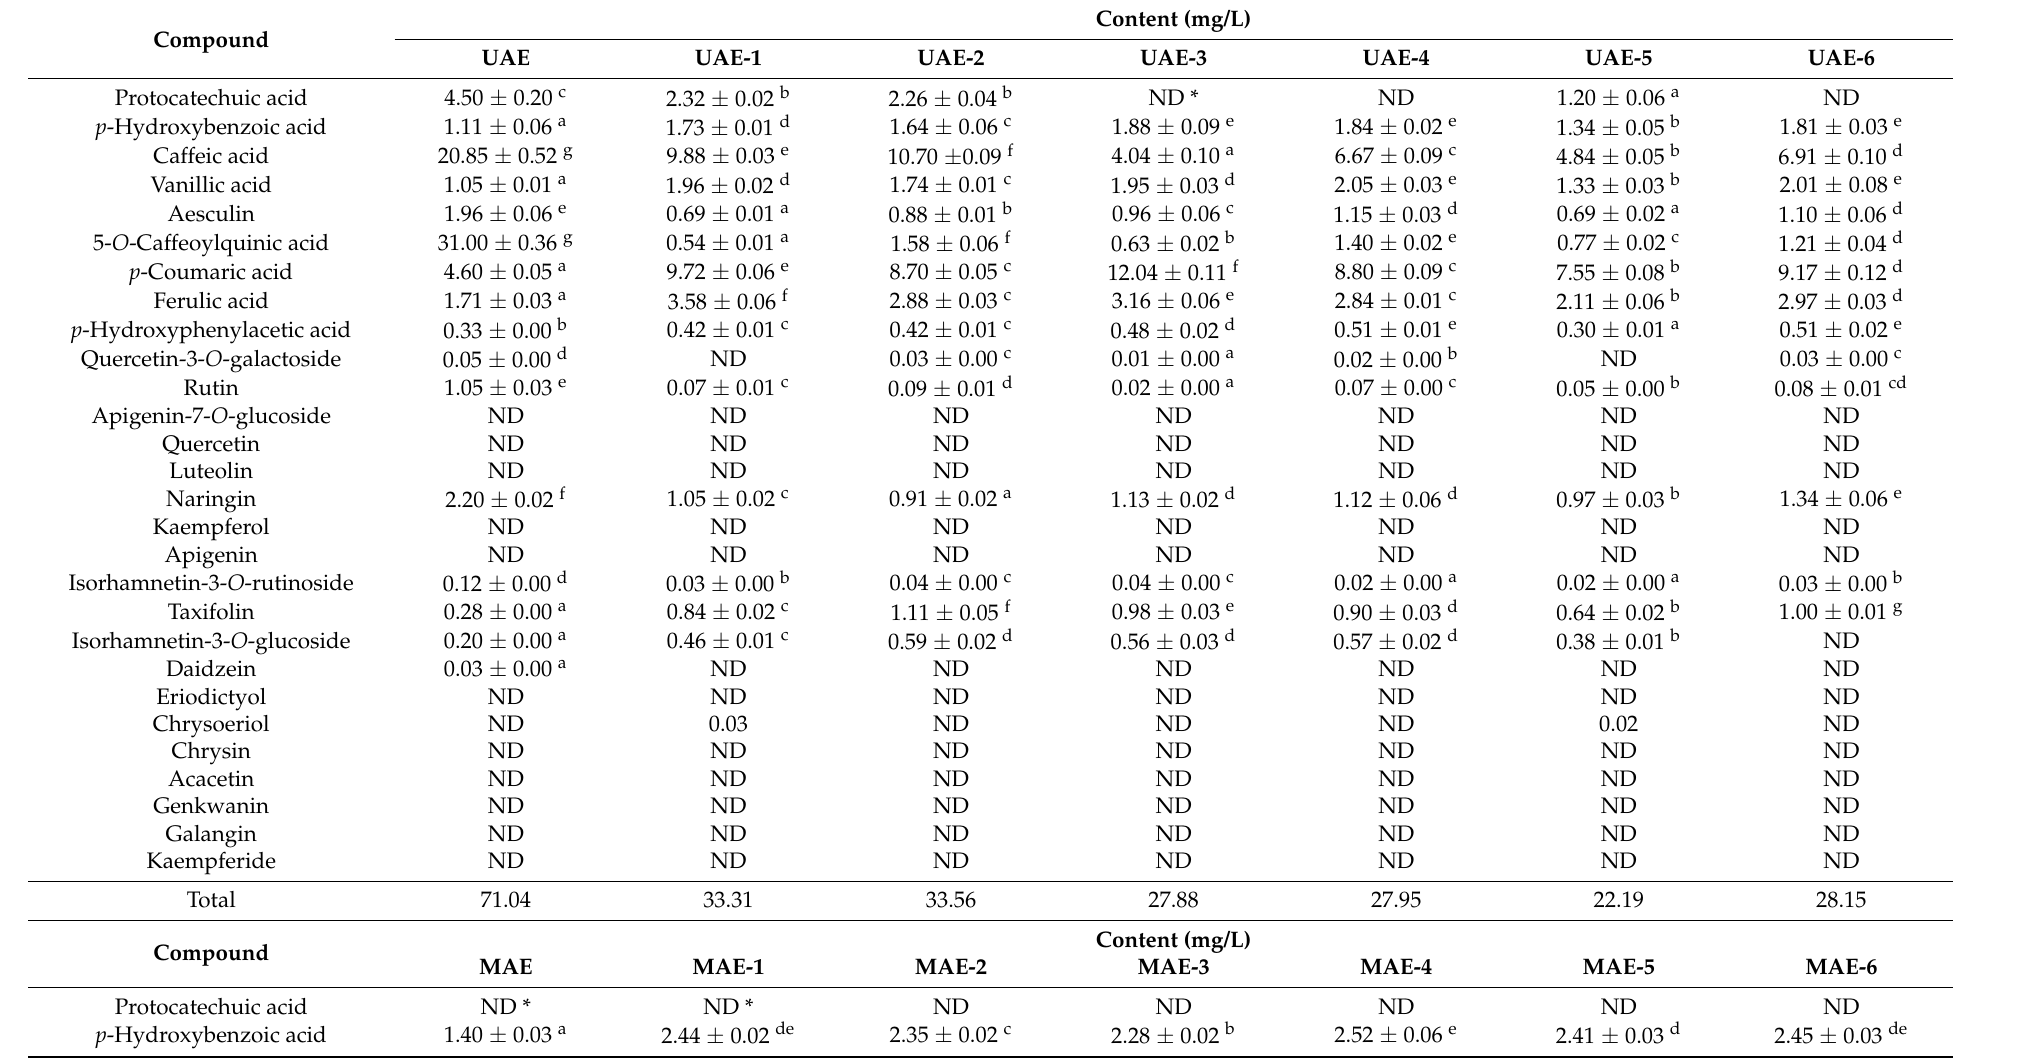
Table 4. Phenolic profile of UAE and MAE extracts of exhausted plant